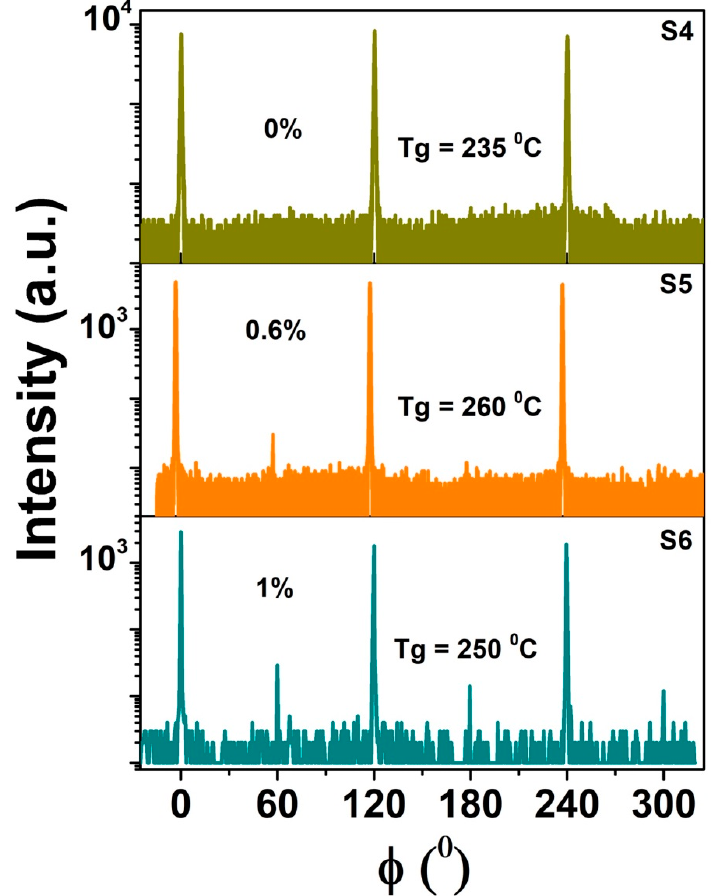
Figure 6. φ scan of (015) plane of the Sb 2 Te 3 and Sb 2 Te 3 /Bi 2 Se 3 samples shown in Figure 5a with the calculated twinning percentages. The dominant set of triplets shown here occurs at the same in-plane angle as the (200) plane re fl ections of the substrate.